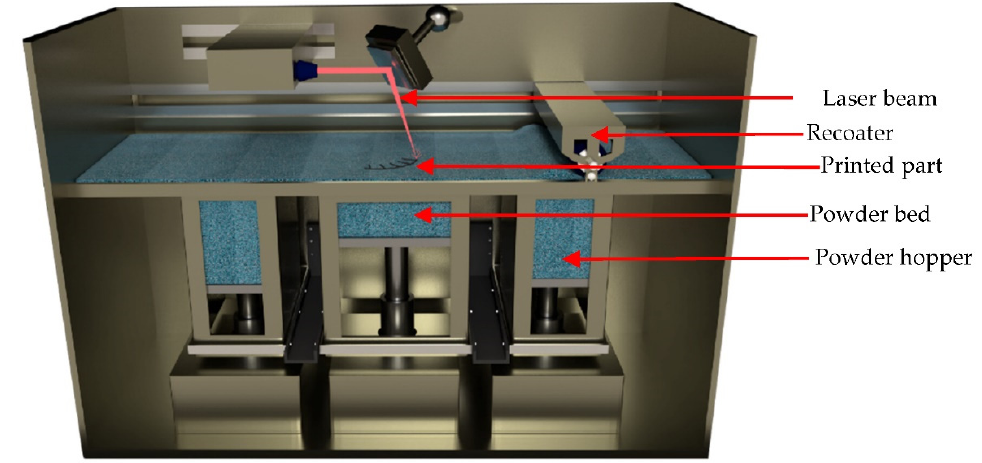
Figure 1. Visualization of the LPBF Technology.